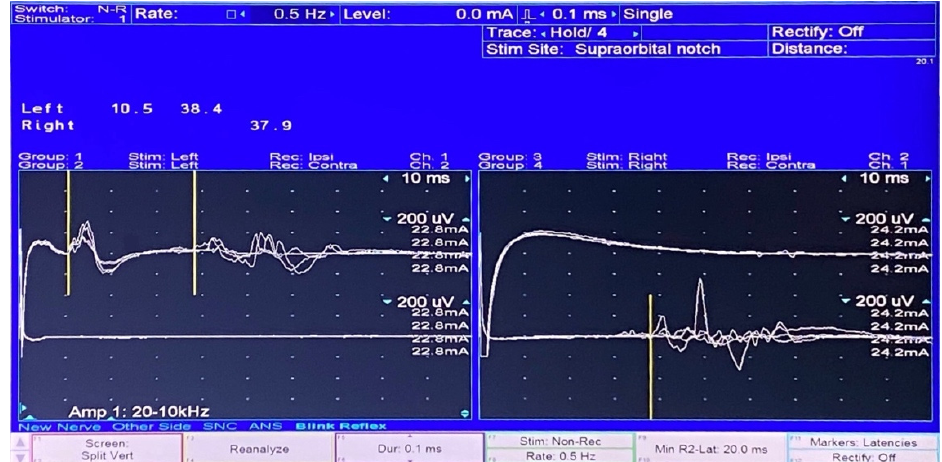
Figure 2. The blink reflex study showed the absent right R1 and R2 when stimulating the right side. Contralateral R2 responses were normal ( right ). The left R1 response was normal when stimulating the left side. Ipsilateral and contralateral R2 responses were normal ( left ).